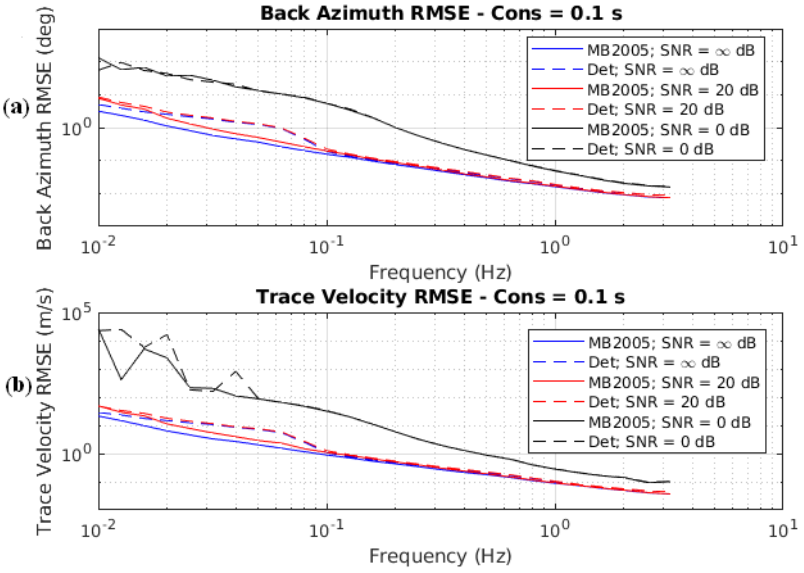
Figure 16. Plots (log-scales) of the ( a ) back azimuth and ( b ) trace velocity RMSE. The solid lines are the results of the MB2005, and the dashed lines are for the sensor (microbarometer and WNRS). The colors represent different noise levels; blue is infinite SNR, red is 20 dB, and green is 0